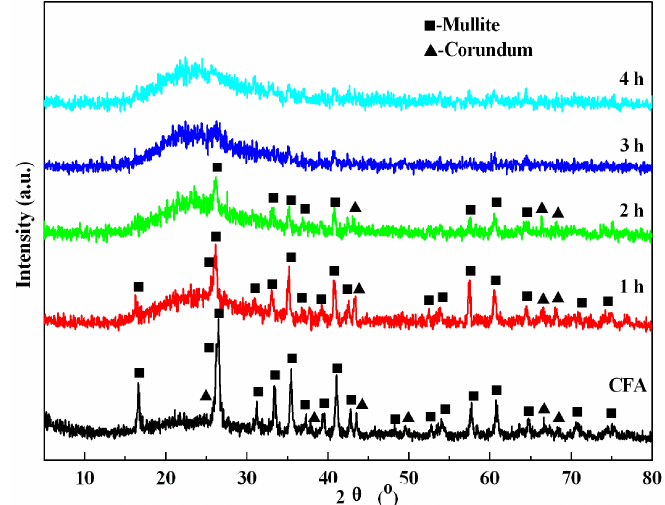
ff erent time periods of